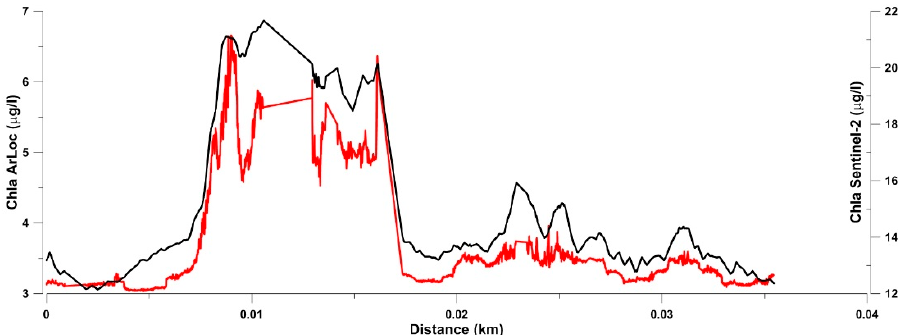
Figure 10. Normalized chlorophyll a trend performed in a representative transect along Blomstrandbreen glacier, (red for ArLoC data and black for Sentinel-2 data).